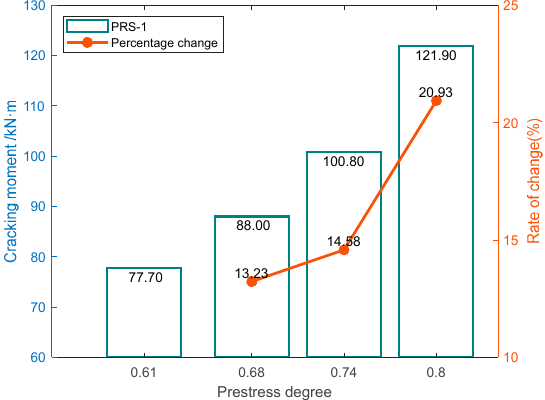
Figure 15. Effect of prestressed steel strand on mid span deflection curve.